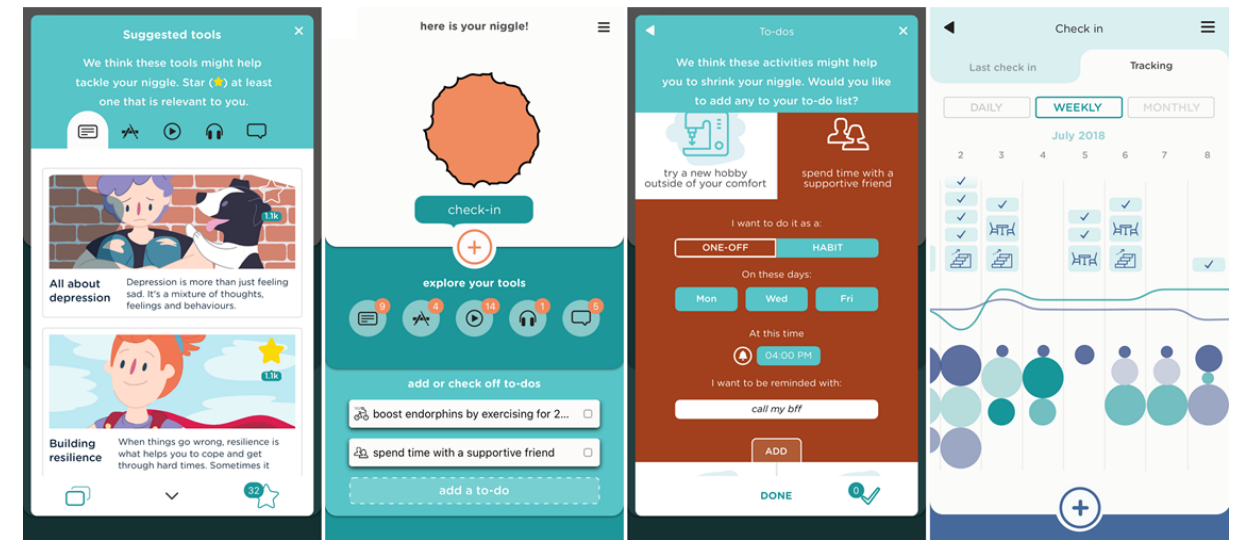
Figure 5. Learning and Planning